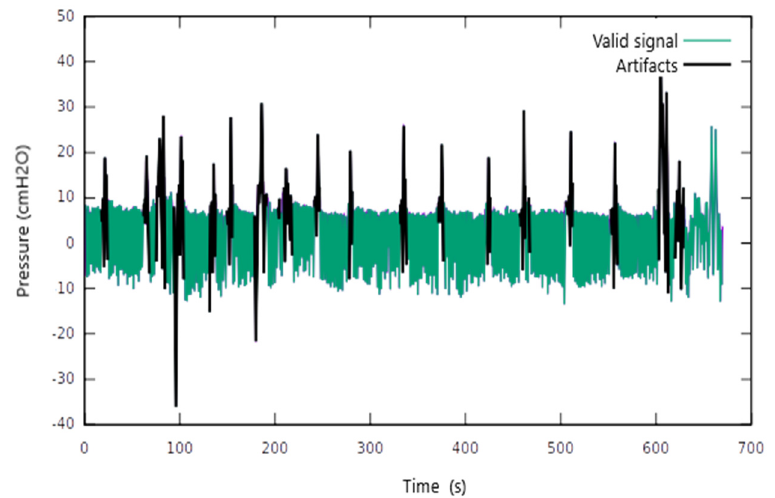
Figure 2. The application of the digital filter to remove the signal artefacts.